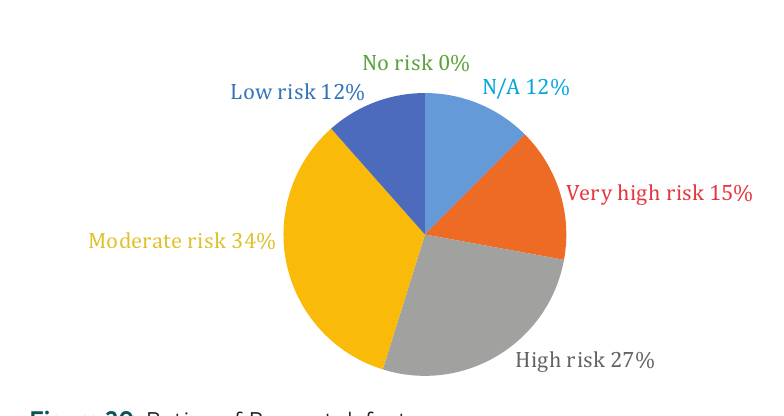
Very high risk 15% High risk